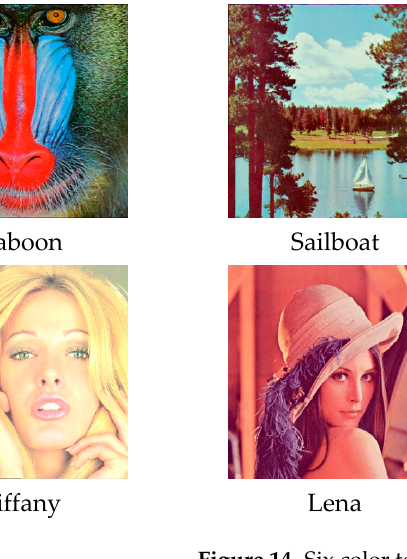
Figure 14. Six color test images in size 512 × 512 and two 64 × 64 size fl ag watermarks.